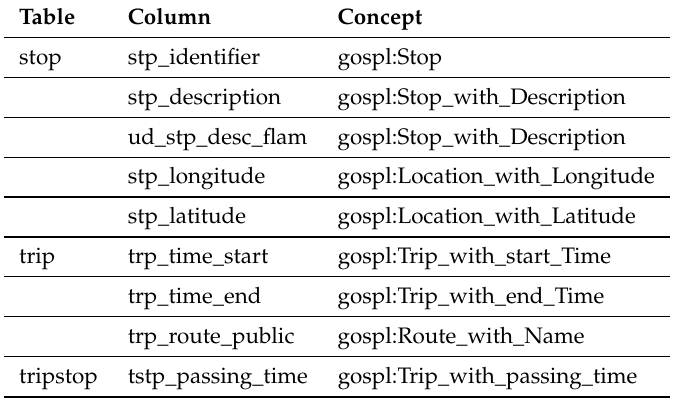
Table 7 shows how the concepts in the ontology map to the columns in the tables of the STIB database. Table 7. Mapping STIB database columns to concepts in the ontology. Table Column